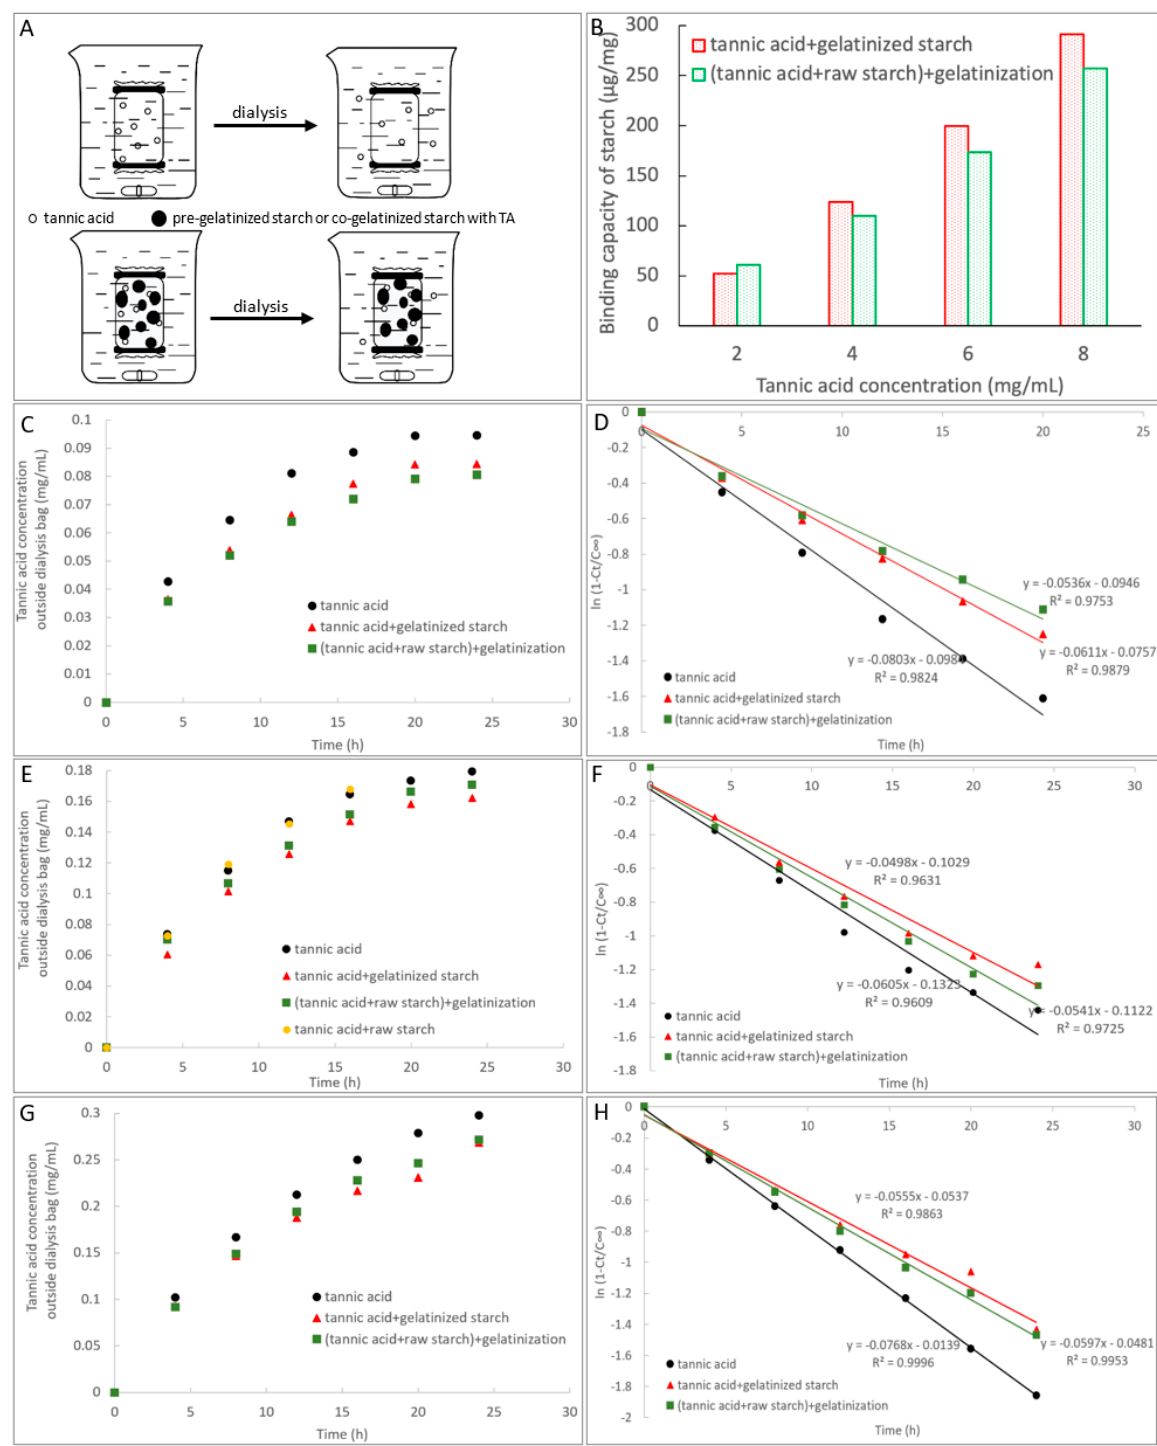
Figure 3. The dialysis scheme of TA for the control (the upper one) and for the TA-starch gelatinized systems (the below one, including two mixing procedures, i.e., mixing TA with pre-gelatinized starch, and co-gelatinizing TA with starch) ( A ). The adsorption capacity (adsorption amount of TA per mass of starch) of starch for two mixing procedures at the dialysis time of 20 h at the low (2 mg/mL) and high (4, 6, and 8 mg/mL) initial TA concentrations in the dialysis bag ( B ). The concentrations of dialyzed TA outside the dialysis bag along with time at 2 ( C ), 4 ( E ), and 6 ( G ) mg/mL of initial TA concentrations inside the bag for two mixing procedures; The logarithm of slope analysis for the fraction of dialyzed TA along with time at 2 ( D ), 4 ( F ), and 6 ( H ) mg/mL of initial TA concentrations inside the bag, from which the transport rate constants k t that reflect the dialysis velocity were